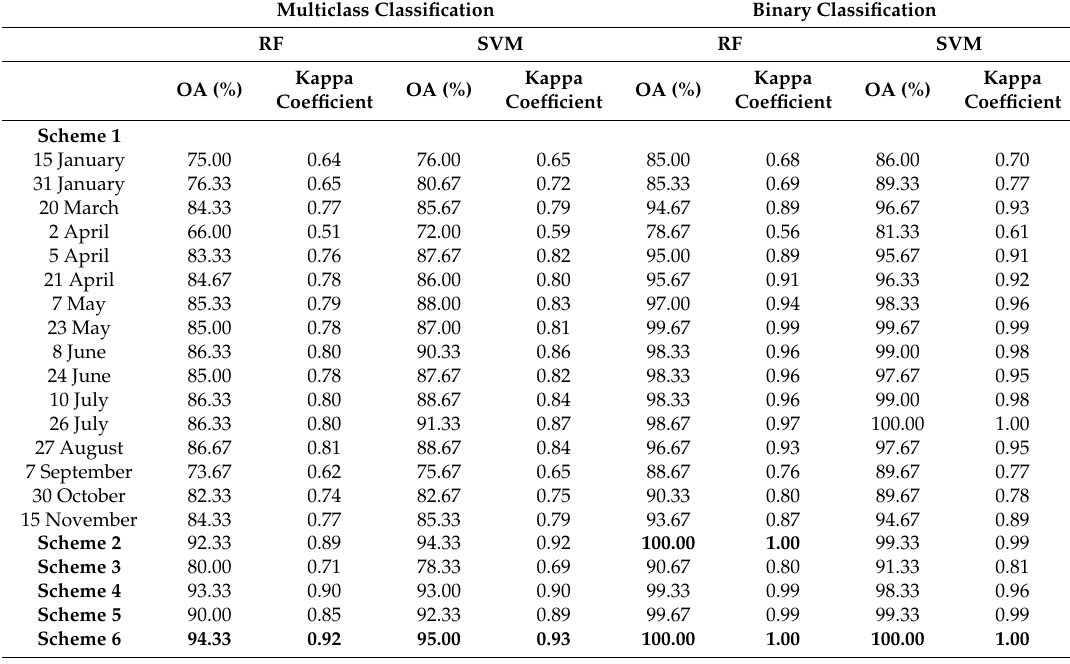
Table 4. Summary of classification accuracies (%) at site A. The highest accuracy identified by model and classification type (i.e., multiclass vs. binary) is shown in